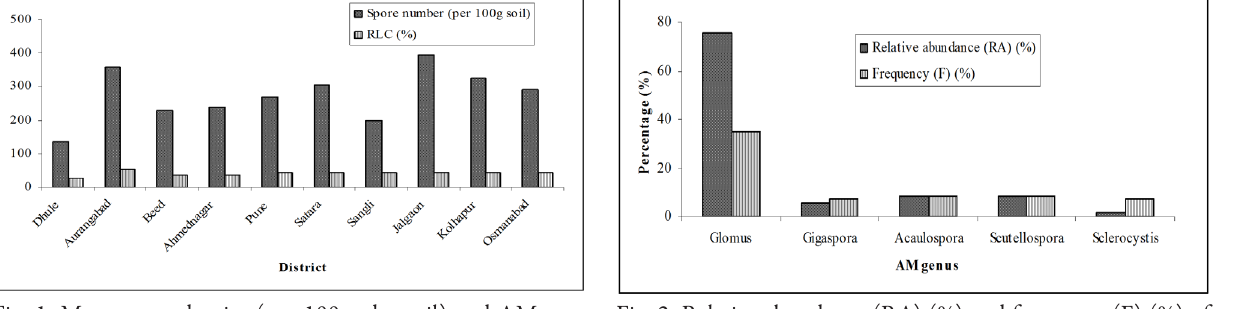
Fig. 2. Relative abundance (RA) (%) and frequency (F) (%) of AM spores identified at genus level from the soil samples. Mean values were calculated from the data obtained in all tehsil places belonging to the particular district